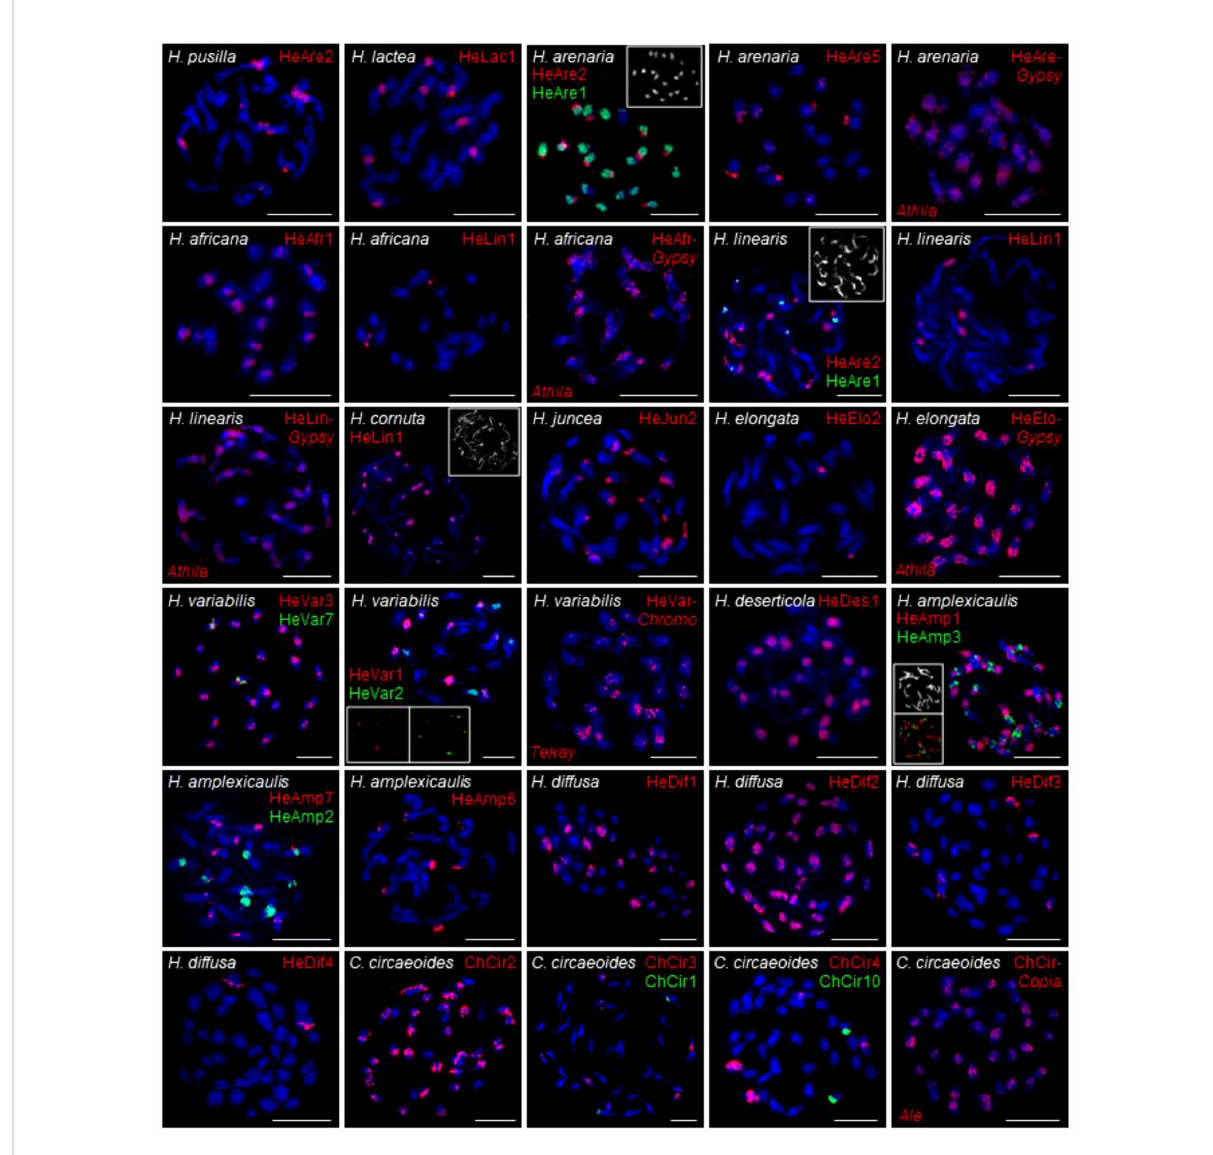
FIGURE 6 FISH localization of the selected tandem repeats and retroelements on mitotic metaphase chromosomes of Heliophila species and C. circaeoides . Chromosomes were counterstained by DAPI; FISH signals are shown in color as indicated. Detailed information on the localized repeats is provided in Supplementary Table 6. Scale bars, 10 m